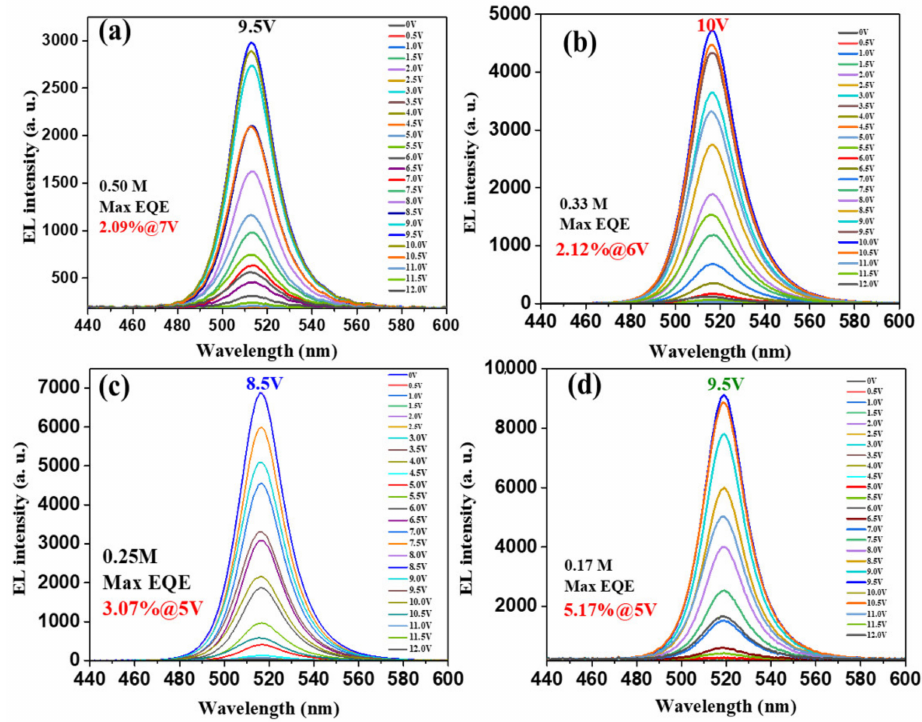
Figure 3. EL curves of the PeLEDs prepared with different concentrations of the perovskite precursor